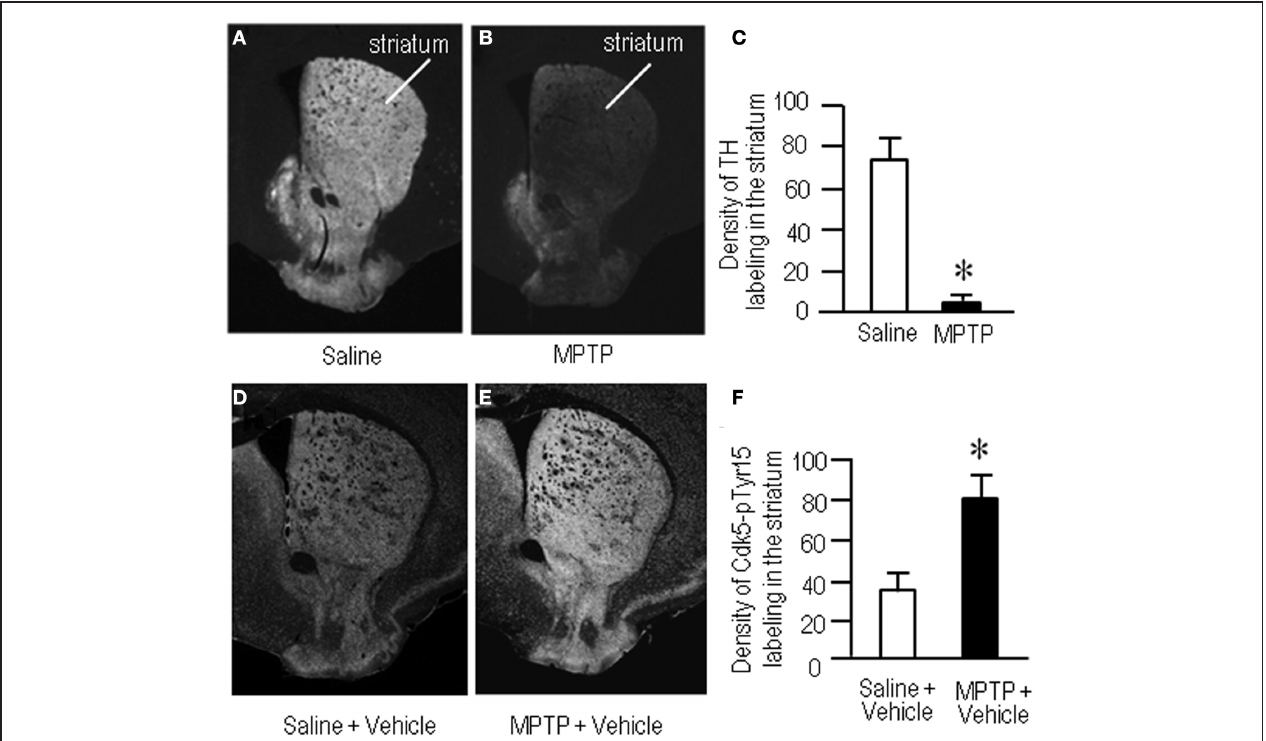
means ± S.E.M. ( n = 5). ∗ P < 0 . 001 versus saline-treated mice, two tailed Student’s t -test. (D–F) Increased density of striatal Cdk5-pTyr15 labeling in MPTP mice. Representative images of striatal sections (0.0–1.0mm anterior to bregma) immunostained for Cdk5-pTyr15 from saline- (D) and MPTP-treated (E) mice. (F) Optical density measurements of striatal Cdk5-pTyr15 labeling in saline- and MPTP-treated mice. Values are mean ± S.E.M. ( n = 5). ∗ P < 0 . 01 versus saline-treated mice, two tailed Student’s t